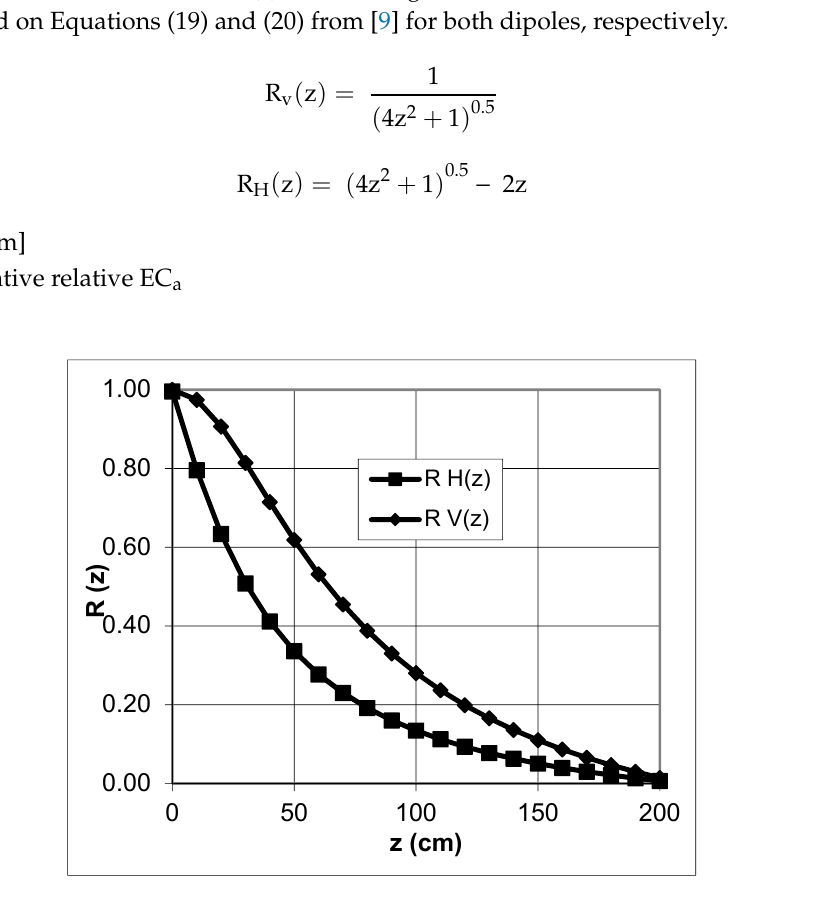
Figure 3. Calculated, relative, cumulative contribution versus depth for vertical (RV(z)) and horizontal (RH(z)) orientated dipoles. Sensors 2019 , 19 , 4293